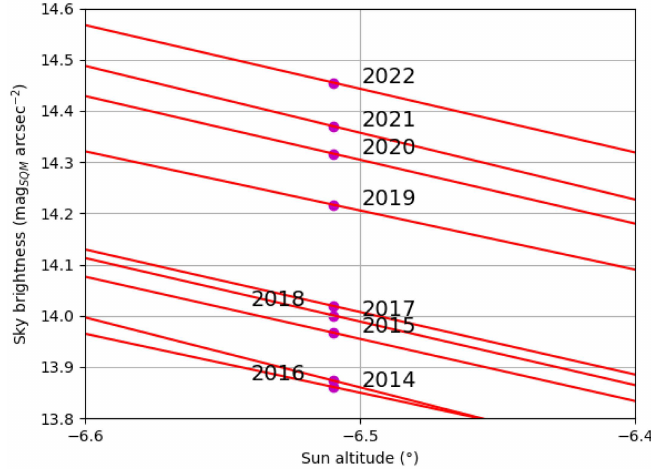
Figure 4. Regression lines of data collected at sunset and dawn at Pennar grouped by years.